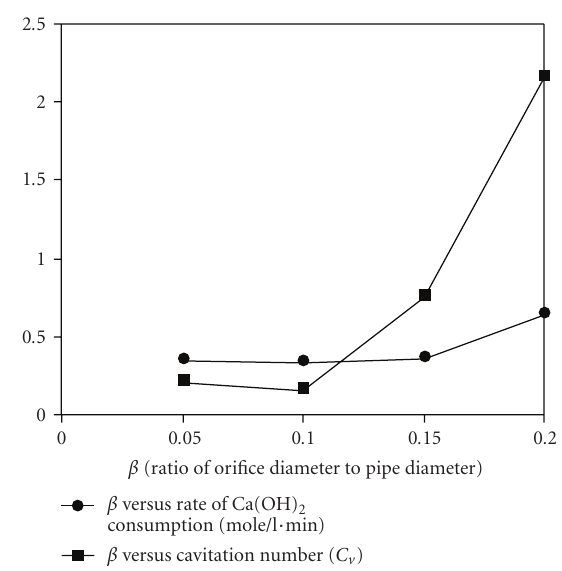
Figure 7: E ff ect of β factor onto rate of calcium hydroxide consumption and cavitation number ( C v